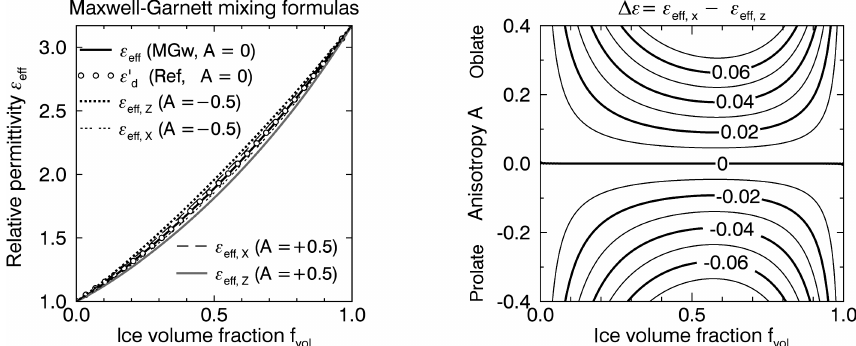
Figure 1. Left panel: relative permittivity ε eff of dry snow with isotropic ( A = 0, solid), vertically ( A =− 0.5, dots), and horizontally oriented ( A =+ 0.5, dashed) inclusions calculated by the weighted Maxwell–Garnett formula (MGw), Eq. (4). Open circles indicate the empirical function Eq. (46) from Wiesmann and Mätzler (1999). Right panel: the dielectric anisotropy, (cid:49)ε = ε eff ,x − ε eff ,z , as a function of ice volume fraction f vol and anisotropy A according to Eq.